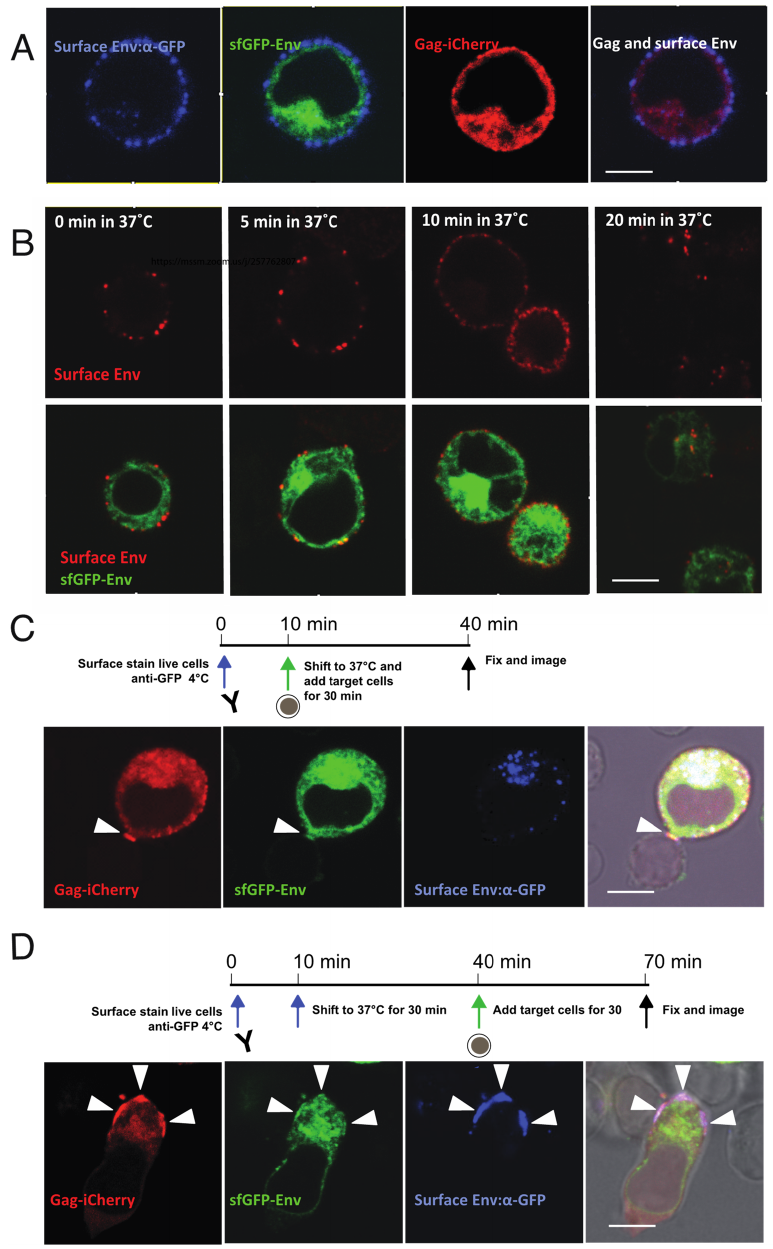
Figure 4. Pulse ‐ chase labeling of cell ‐ surface Env illustrates internalization of Env and relocalization to VS. ( A ) Live cell surface staining of V4.2 ‐ Gag ‐ iCherry: nucleofected Jurkat cells stained with anti ‐ GFP antibody at 4 °C. ( B ) Pulse ‐ chase of surface Env to determine time required for endocytosis: cells with surface ‐ stained Env were shifted from 4 °C to 37 °C and kept for indicated time prior to fixation and imaging. ( C ) Stained cell according to the timeline was immediately co ‐ cul ‐ tured with primary CD4 target cells for 30 min at 37 °C and fixed for imaging. ( D ) Stained cell according to the timeline was first incubated at 37 °C for 30 min, then co ‐ cultured with primary CD4 target cells for another 30 min at 37 °C and fixed for imaging. Arrowheads show VS. Bar: 6 μ m.